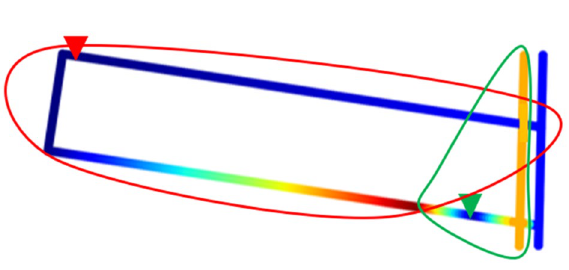
Figure 14. The monitoring scopes of the two water level sensors at 1507 working